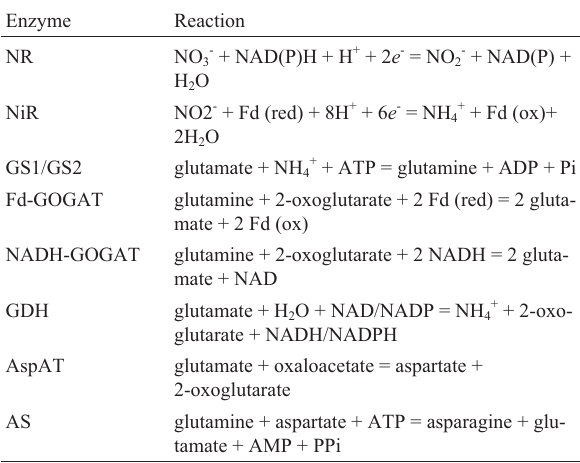
Table 1 - Enzymes and biochemical reactions for plant nitrogen assimilation (Lam et al. , 1996). Enzyme